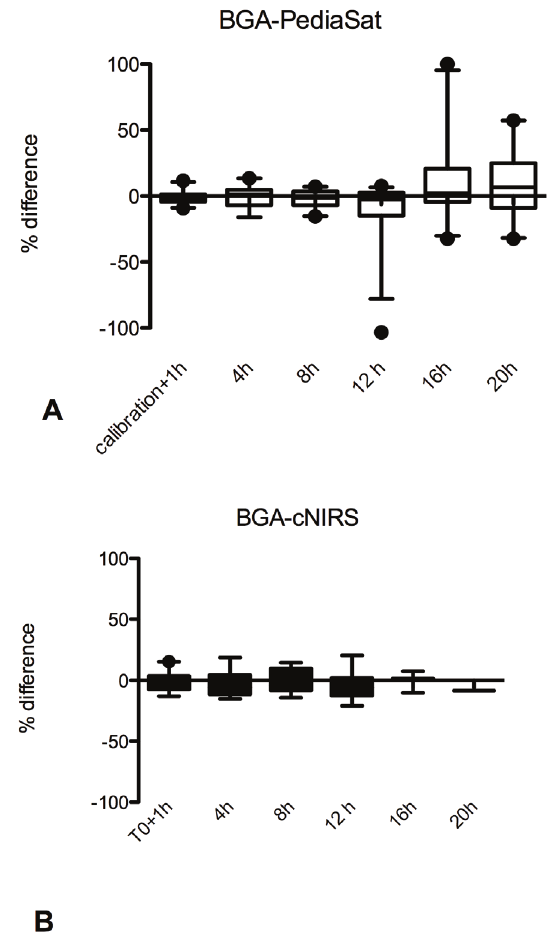
Figure 1. Saturation differences over time. Percentage difference between ScvO2 values obtained by blood gas analysis (BGA) and PediaSat I ( A ), and BGA and cerebral near infrared spectroscopy (cNIRS) ( B ), expressed over time. Table 2. Median and range percentage differences between ScvO2 reference values (achieved by catheter withdrawn blood gas analysis) and PediaSat/cerebral Near Infrared Spectroscopy